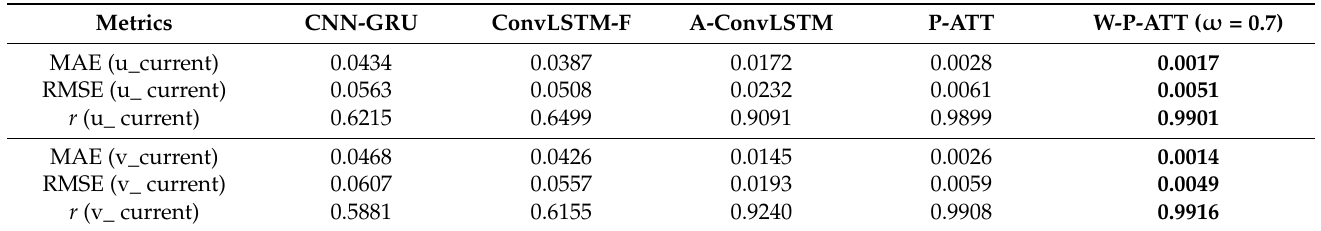
Table 2. MAE, RMSE, and r for five different models; the values in bold mean the best